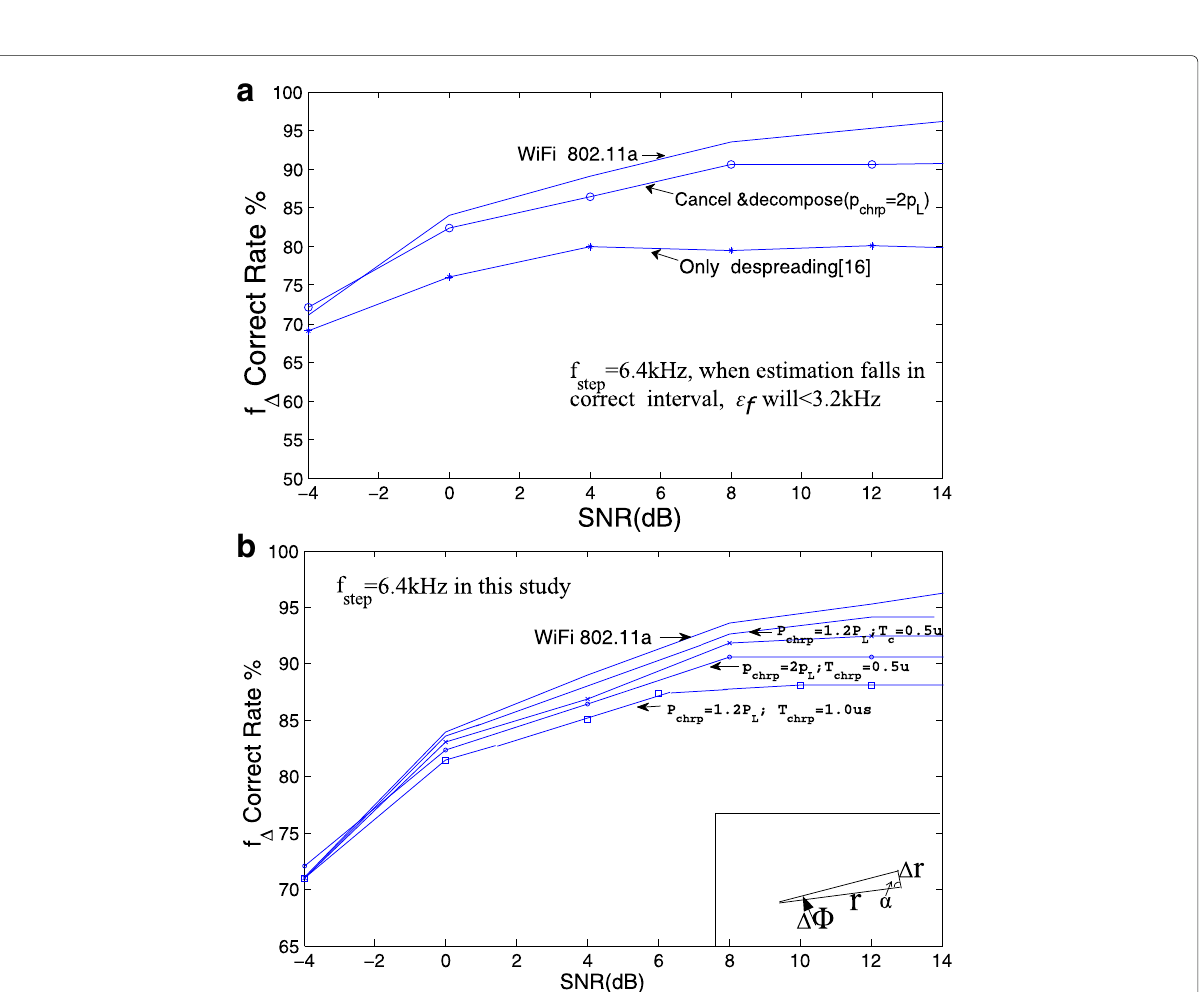
Fig. 4 Frequency offset estimation result. a Canceling and decomposing vs. only de-spreading. b Powers of chirps overlapped are